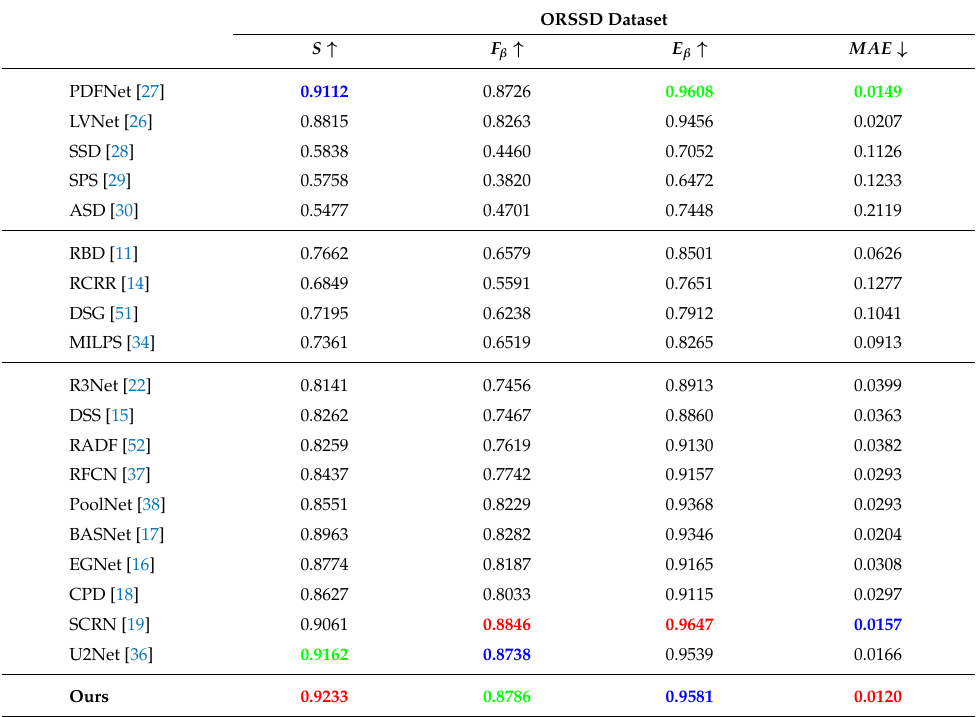
Table 1. Quantitative comparison results of S-measure, max F-measure, max E-measure, and MAE on the ORSSD dataset. Here, “ ↑ ” (“ ↓ ”) means that the larger (smaller) the better. The best three results in each row are marked in red, green, and blue,